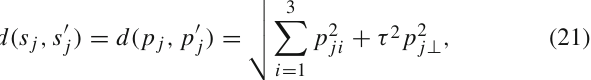
dimensional momenta with p 1 = 2 and q 1 = − 2 in arbitrary units. Since there is only one possible pairing of momenta, the event distance is d 2 ( s , s (cid:6) ) = d ( p 1 , q 1 ) = 4 using the spatial p = 2 norm and d 2 ( s , s (cid:6) ) = d 2 ( p 1 , q 1 ) = 16 when using the